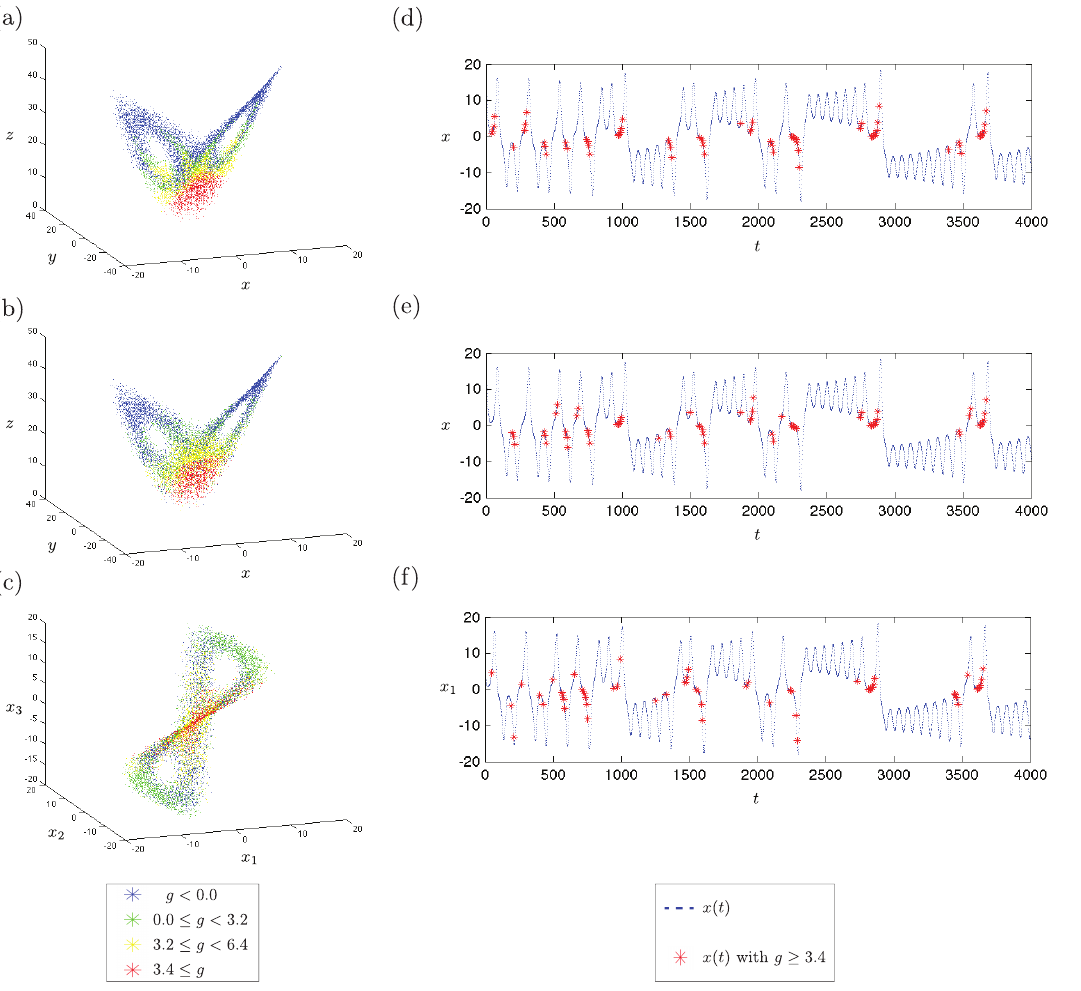
Figure 1. The first column of figures depicts the growth rates of bred vectors in the Lorenz system using three different methods: (a) standard breeding in the phase space (x,y,z) ; (b) nearest-neighbor breeding in the phase space (x,y,z) ; and (c) nearest-neighbor breeding in the reconstructed phase space (x 1 ,x 2 ,x 3 ) . The colored points correspond to negative (blue), low (green), medium (yellow), and high (red) growth. The second column of figures depicts the first coordinate of phase space as a function of time, with red stars indicating the points with high-growth-rate ( g i ≥ 6 . 4) bred vectors for the three different methods: (d) standard breeding in the phase space (x,y,z) ; (e) nearest- neighbor breeding in the phase space (x,y,z) ; and (f) nearest-neighbor breeding in the reconstructed phase space (x 1 ,x 2 ,x 3 )